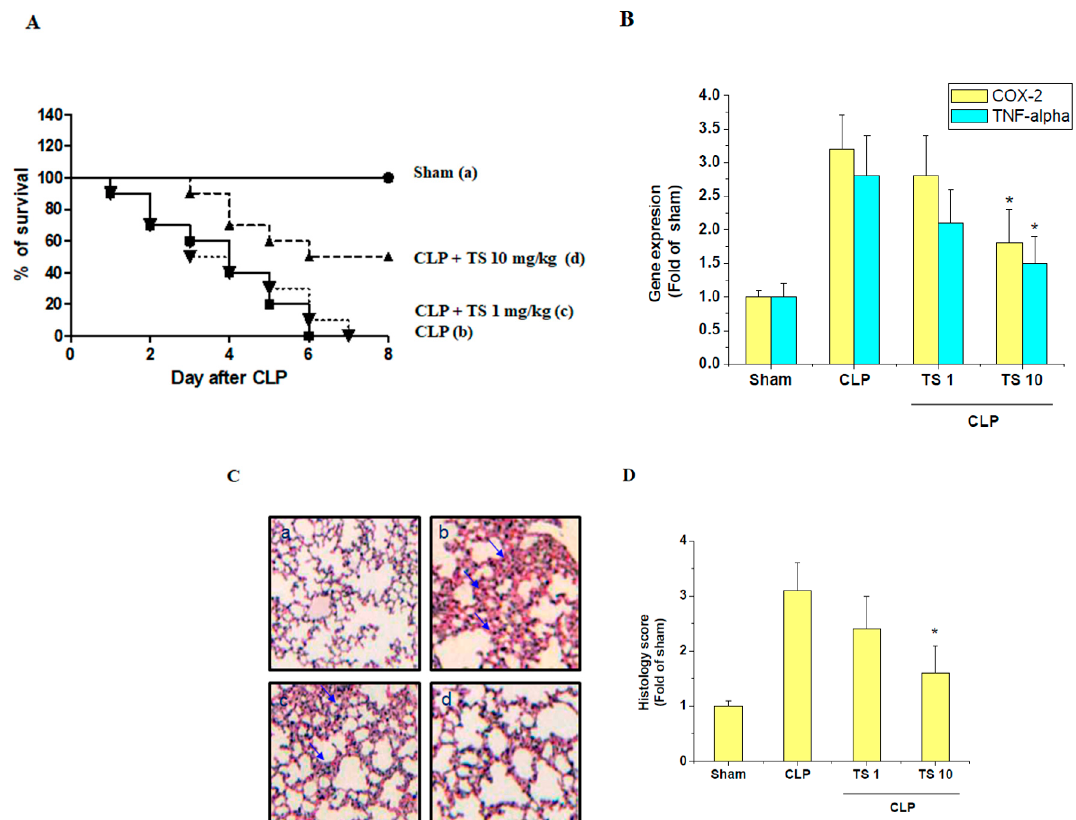
Figure 1. Effect of TS on survival and lung injury in cecal ligation and puncture (CLP)-induced septic mice. ( A ) To examine the effect of TS on the survival of CLP-induced septic mice, survival of mice was then monitored every 24 h for up to 8 days for the following experimental groups (a) sham control; mice were orally administered with either (b) vehicle (corn oil, 0.1 mL per mouse, n = 5), (c) 1 mg/kg TS ( n = 5), or (d) 10 mg/kg TS ( n = 5), 2 h prior to the operation. Significantly different from CLP-induced septic group ( B ) Expression of COX-2 and TNF- α transcripts in the isolated PAM were determined by real-time PCR; * p < 0.05 vs. CLP-induced septic group ( n = 3 in each group) ( C ) The lungs from each experimental group were processed for histologic evaluation 1 day after CLP. Representative histologic changes in lung tissue obtained from mice belonging to each group are displayed and the arrows indicate the damaged area (hematoxylin and eosin staining; magnification 400×). Scale bar represents 200 um. ( D ) The extent of lung injury was estimated using scores in different sections for neutrophil infiltration, hemorrhage, necrosis, congestion, and edema. * p < 0.05 vs. CLP-induced septic group ( n = 3 in each group).